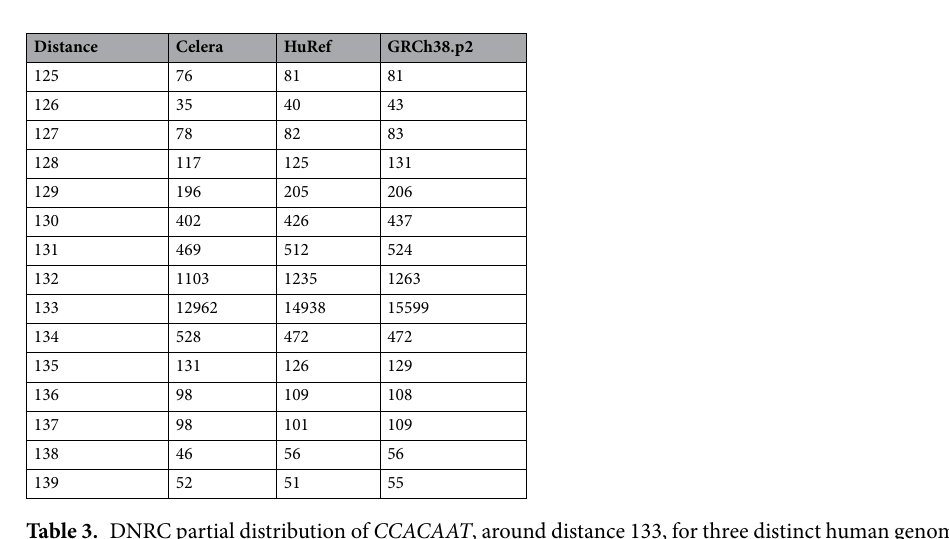
Figure 6. DNRC distribution f w , w ′ for w = CCACAAT , and global DNRC distribution, f k = 7 , for the complete human genome. Very strong enrichment of distance 133: f w , w ′ (133) = 0.455 (left). The right plot is a zoom of y axis.